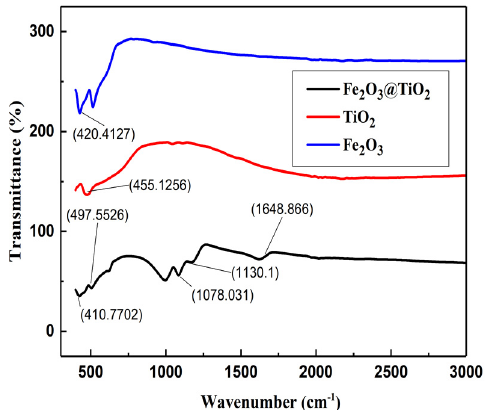
Figure 4. FTIR plot for α -Fe 2 O 3 @TiO 2 nanocomposites ( blue ) TiO 2 result pristine powder ( red ) Fe 2 O 3 pristine powder ( black ).